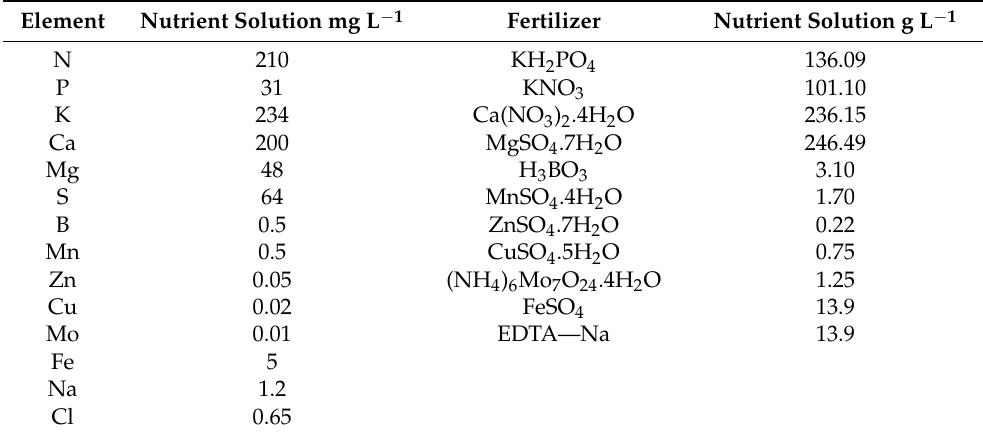
Table 1. Chemical composition of nutrient solution of Hoagland and Arnon (1950), used in the hydroponic cultivation of